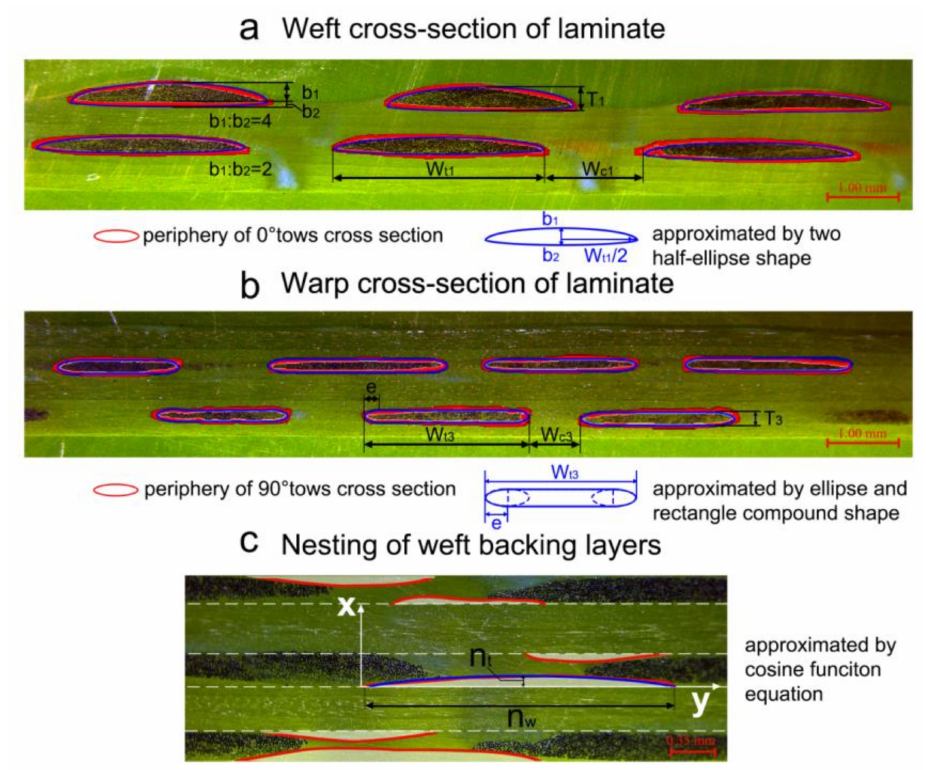
Figure 8. Shapes fitting for ( a ) 0 ◦ tows cross-sections; ( b ) 90 ◦ tows cross-sections; ( c ) nesting deformation of weft backing